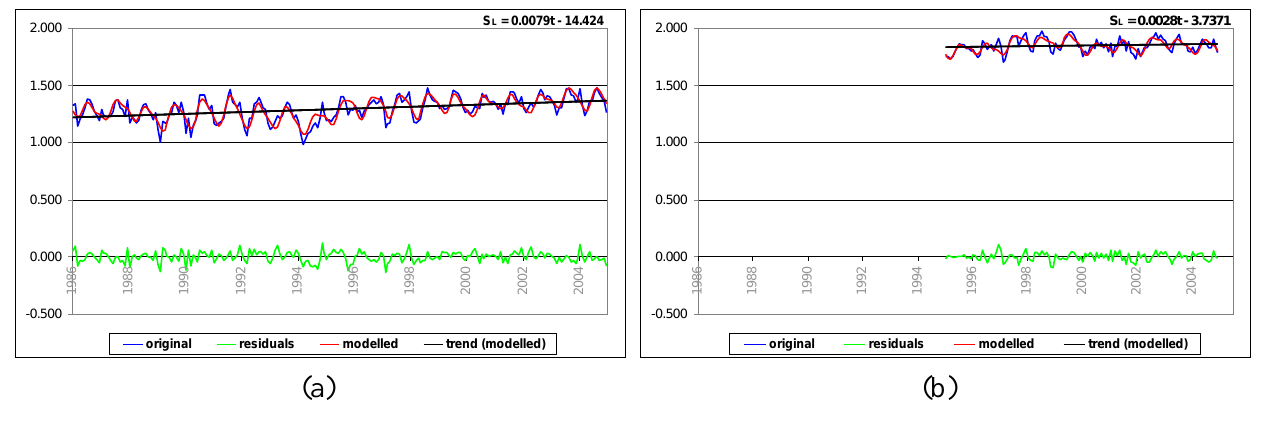
Figure 7. Original sea-level data ( f ) vs . the modeled time series after LSSA ( g ) with the trend (modeled) and the residuals ( v ) for the (a) Antalya-II and (b) Erdek tide